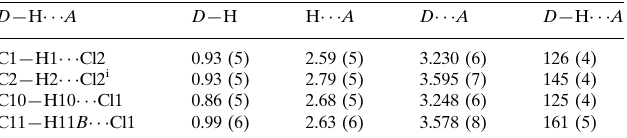
Hydrogen-bond geometry (A ˚ , (cid:2)